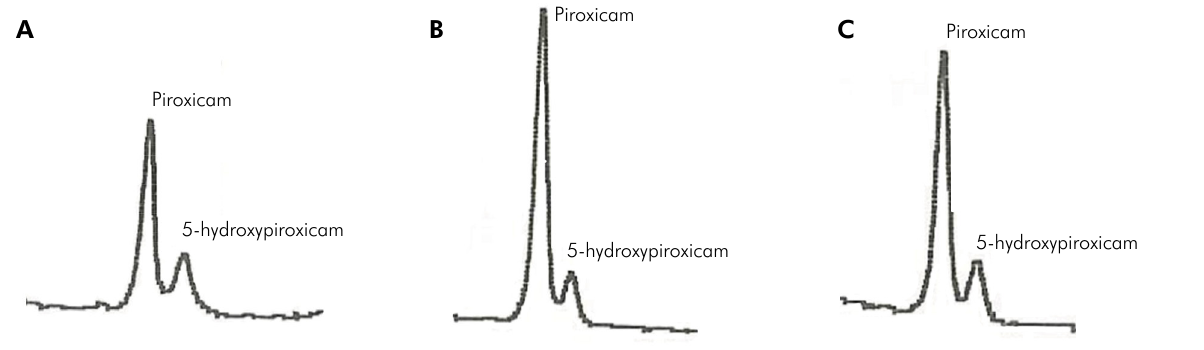
Figure 3. Representative chromatograms of the spectrophotometric signal versus time for piroxicam (retention time ~11 min) and 5-hydroxypiroxicam (retention time ~12 min). (A) chromatogram from the analyte of volunteer 6 at 72 h and (B) 48 h; (C) chromatogram from the analyte of volunteer 7 at 72